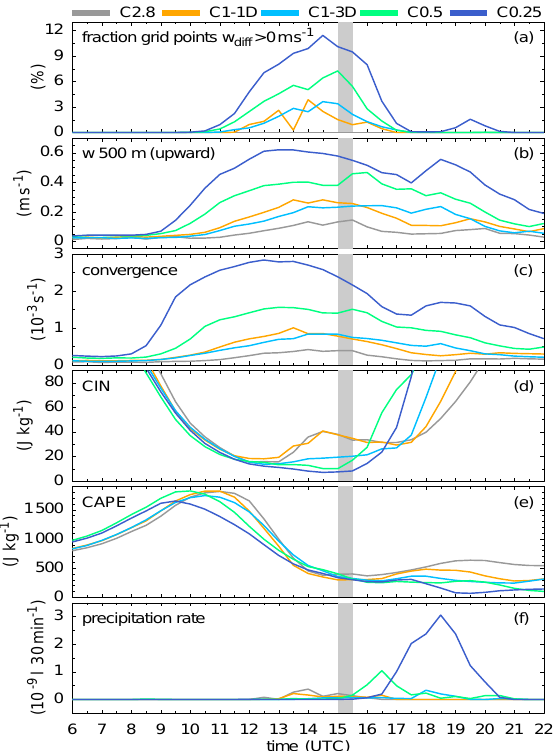
Figure 16. Domain-averaged fraction of grid points with positive w diff (a) , vertical wind at 500ma . g . l . (b) (only upward compo- nents), 10m wind convergence (c) , convective inhibition (d) , con- vective available potential energy (e) , and precipitation rate (f) on 23 July 2013. The gray shaded areas indicate the time of convection initiation of the C0.25